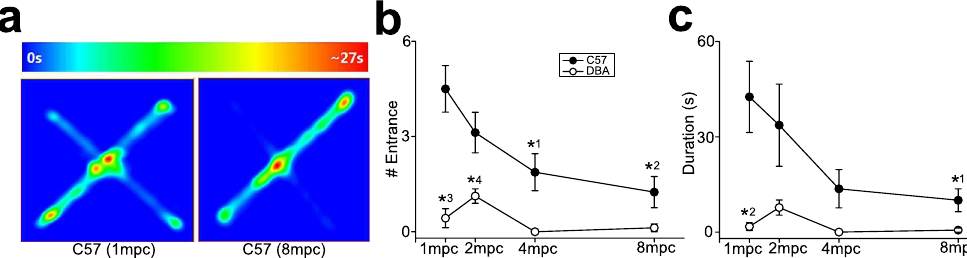
Figure 6. The effects of housing density on anxiety of mice. ( a ) Examples of heat maps for time and locations that C57 mice under 1 mpc and 8 mpc conditions spent in the elevated plus maze test. ( b ) A graph showing a number of opened arm entrance in the elevated plus maze. * 1 p = 0.004 for 1 mpc vs. 4 mpc in C57, * 2 p < 0.001 for 1 mpc vs. 8 mpc in C57, * 3 p < 0.001 for C57 vs. DBA under 1 mpc, * 4 p = 0.038 for C57 vs. DBA under 2 mpc. ( c ) A graph similar to ( b ), but showing duration that mice stayed in the opened arms. * 1 p = 0.023 for 1 mpc vs.